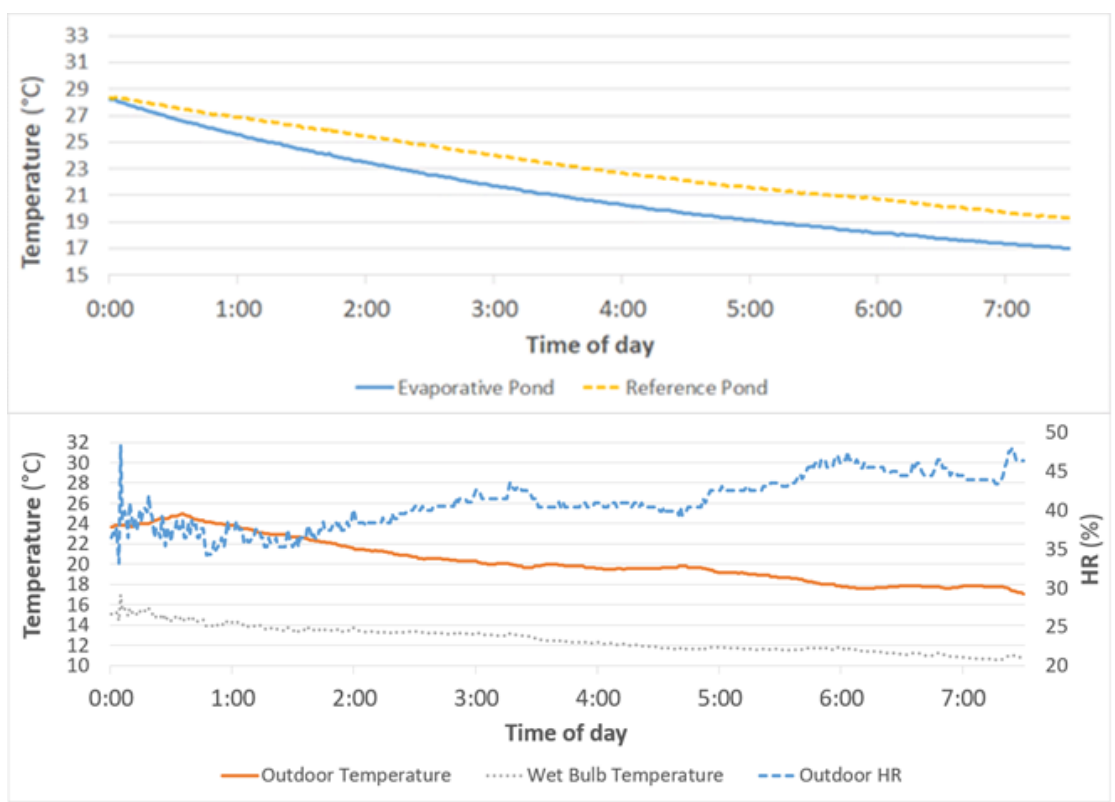
Figure 9. Water temperature fluctuations in the reference pond and in the evaporative pond with HARDI ISO F-110-06 nozzles ( up ) and environmental conditions: dry-bulb temperature, wet-bulb temperature, and humidity ratio HR ( down ).